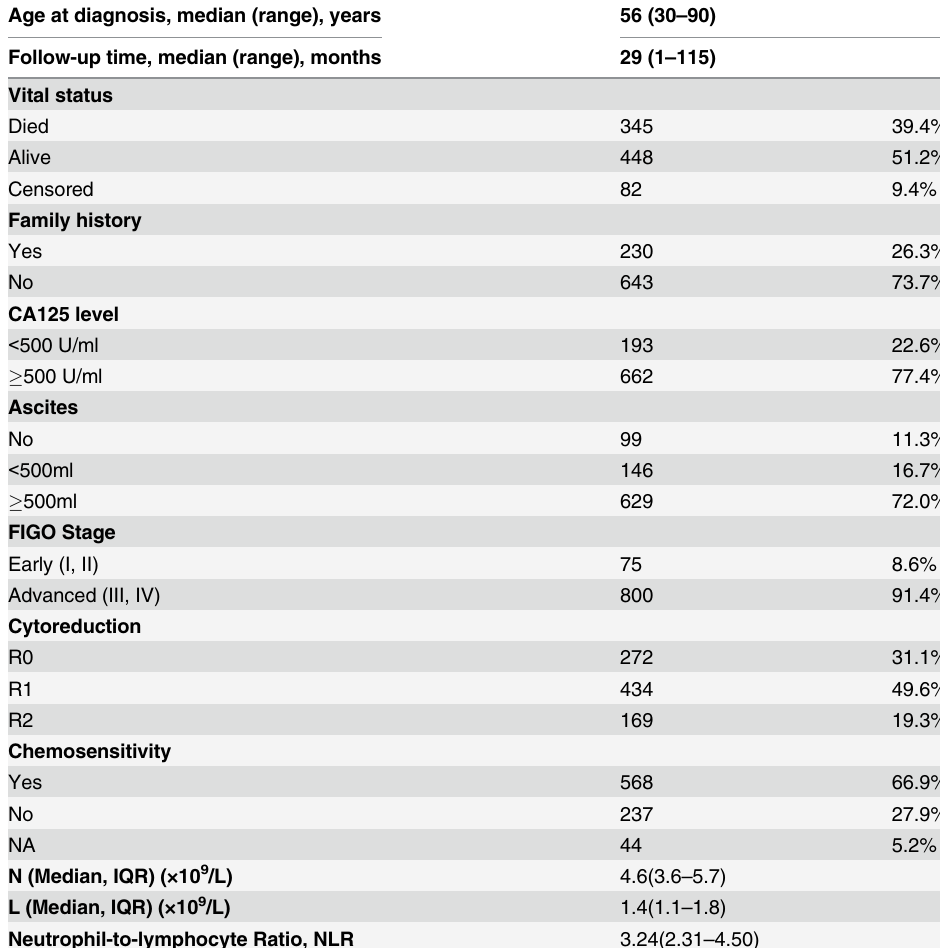
Table 1. Patient Characteristics (n =